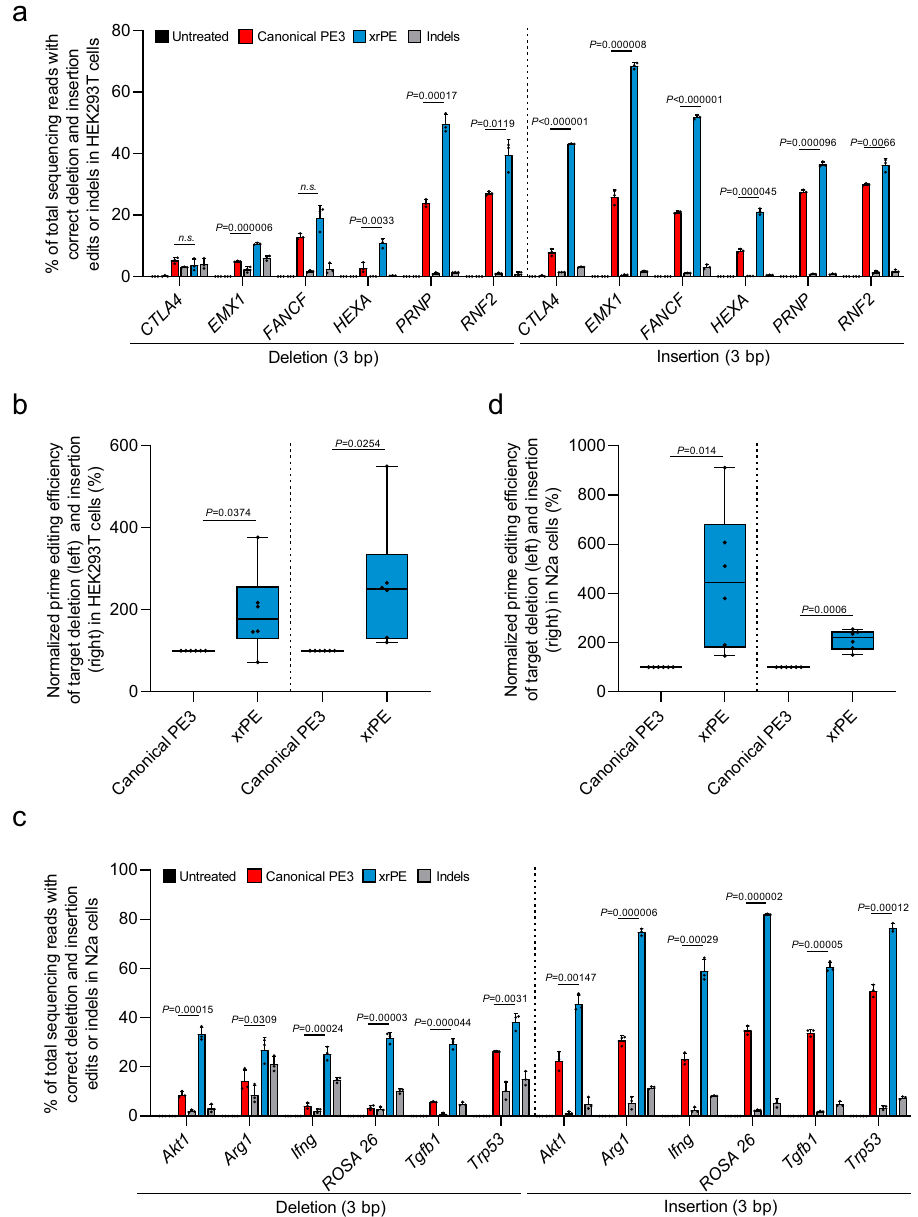
Fig. 4 The xrPE shows enhanced performance for precisely introducing small deletions and small insertions in multiple cell types. a HEK293T cells were transfected with plasmids for canonical PE3 or xrPE targeting 6 individual sites for 3-bp deletions and 3-bp insertions, separately. Correct editing ef fi ciencies were determined by deep-sequencing (mean ± SD, n = 3 biological replicates). Gray bars next to those for PE3 (red) and xrPE (blue) indicate the indel frequencies associated with each tool. The same set of indel data from untreated cells (background) were presented for deletions and insertions. b Results in a is further analyzed by considering editing at all sites ( n = 6 sites for deletions and insertions, respectively) as a whole. The editing frequencies induced by canonical PE3 were set as 100%. c . The experiment similar to a was carried out in N2a cells (at 6 individual sites for 3-bp deletions and 3-bp insertions, respectively). The rates for correct editing and indel formation are shown (mean ± SD, n = 3 biological replicates). The same set of indel data from untreated cells (background) were presented for deletions and insertions. d Results in c were further analyzed by considering editing at all sites ( n = 6 sites for deletions and insertions, respectively) as a whole. The editing frequencies induced by canonical PE3 were set as 100%. Multiple t tests (two-tailed) were performed in data from a , c . Discoveries were determined using the two-stage linear step-up procedure of Benjamini, Krieger, and Yekutieli, with Q = 1%. When discoveries are made (10/12 in a and 12/12 in c ), the exact P values (unadjusted) are shown on the graphs. Otherwise, the comparisons are marked by n.s. not signi fi cant, where the corresponding P values are 0.315 ( − 3 bp in CTLA4 ) and 0.062 ( − 3 bp in FANCF ), respectively. In the box plots shown in b , d , each data point represents the averaged editing activity at the particular site. The center line shows medians of all data points and the box limits correspond to the upper the lower quartiles, while the whiskers extend to the largest and smallest values. Two-tailed one-sample Student ’ s t tests were performed (with P values marked). Source data are provided as a Source Data fi